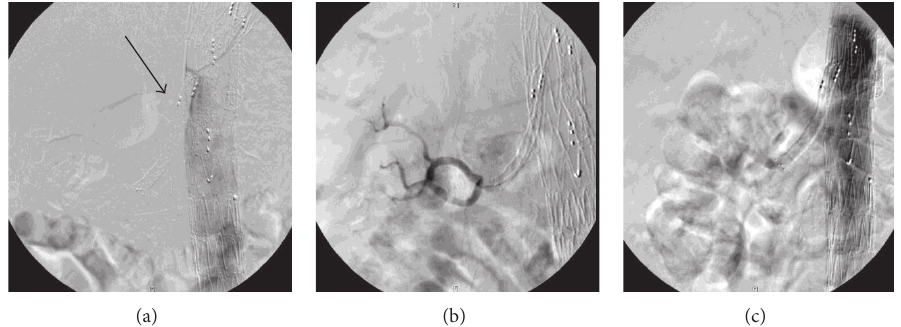
Figure 2: (a) Angiography (via left brachial access) just proximal of the right renal branch of the stent graft showing occlusion of the side branch in the renal artery (arrow). No opacification of the right kidney is identified, consistent with absent perfusion to the right kidney. (b) EKOS thrombolysis catheter with a working length of 6 cm (EKOS Endowave system; EKOS Corporation, Bothell, WA, USA) placed through side branch into right renal artery with filling of segmental renal artery branches after contrast injection. (c) Patent side branch after successful thrombolysis.